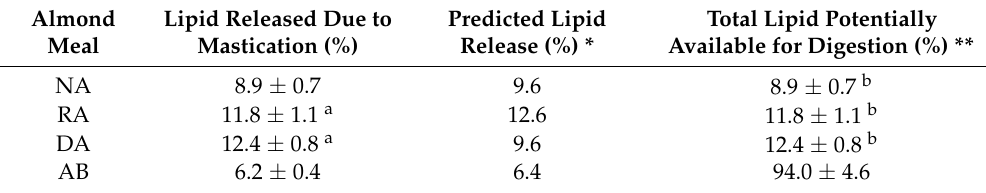
Table 1. Lipid released during mastication (%) and predicted lipid release (%) from natural raw almonds (NA, n = 4), roasted almonds (RA, n = 4), diced almonds (DA, n = 4) and almond butter (AB, n = 4) due to sample processing and mastication. Values represent the average ± SD (standard